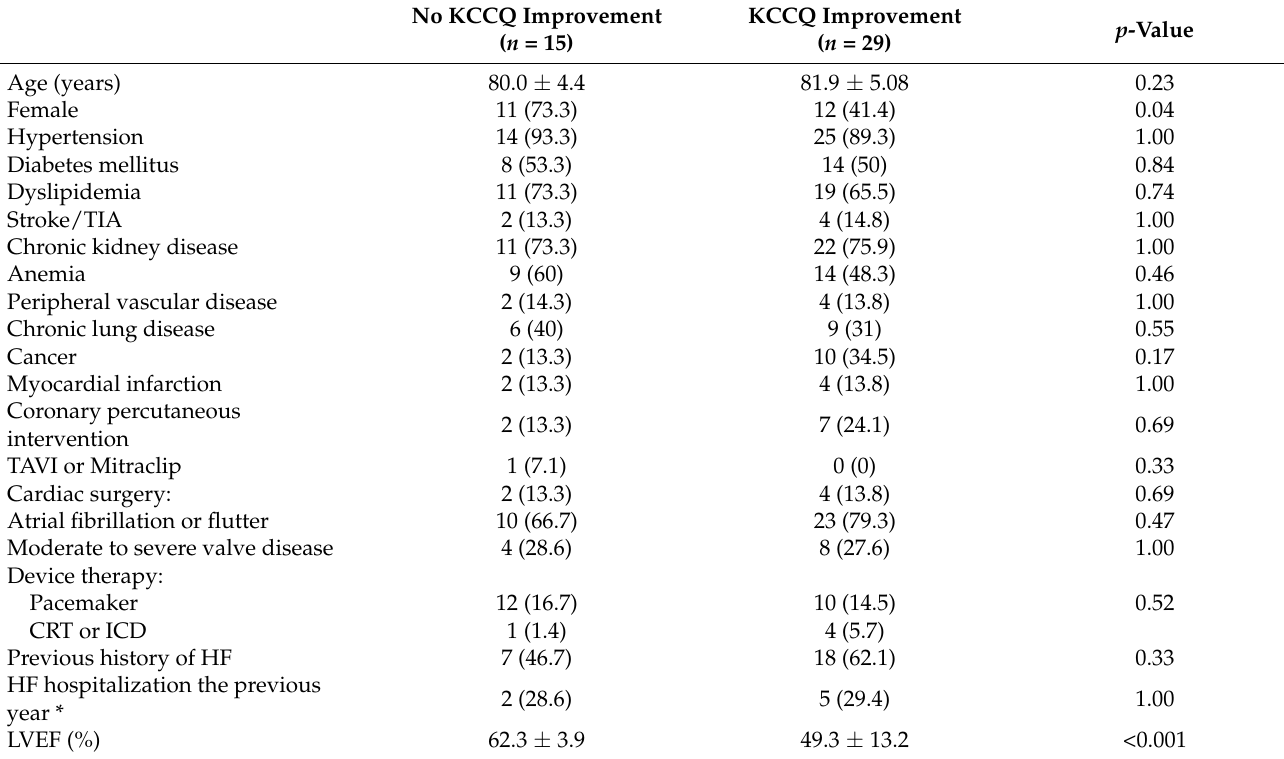
Table 4. Baseline clinical and demographic characteristics of the patients included in the study according to the improvement of KCCQ-12 at one-year follow-up.